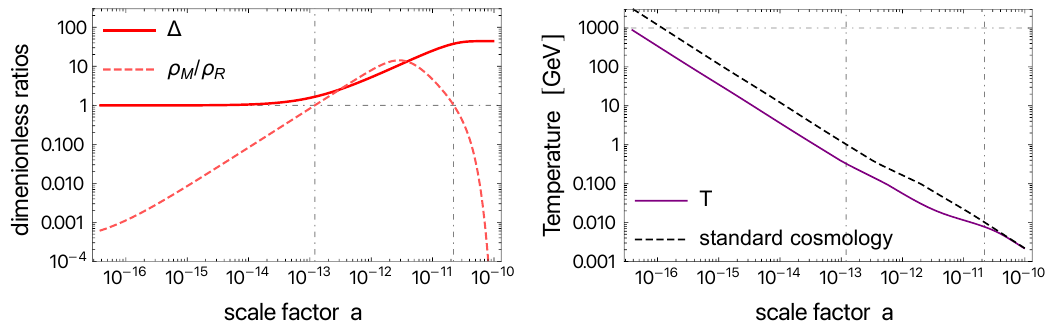
Figure 4 . Evolution of the dark sector with an early matter-domination epoch as a function of the scale factor (normalized to a present value a 0 = 1 ) for m χ = 1 TeV, τ = 10 − 2 sec, and ξ i = 0 . 3 . The 2 left panel shows the evolving ratio of matter-to-radiation energy densities, ρ M /ρ R (dashed line), and ∆ — the ratio of entropy density defined by a 3 ( ρ M + ρ R ) 3 / 4 to its initial value (solid line); see eq. (2.14). In the right panel, the purple solid (black dashed) line shows the evolution of the SM temperature T in our model (in standard cosmology). In both panels, the vertical gray lines depict the beginning (end) of this epoch at a α ( a β ), while horizontal gray lines correspond to unity in left panel, and T = m χ in right 2